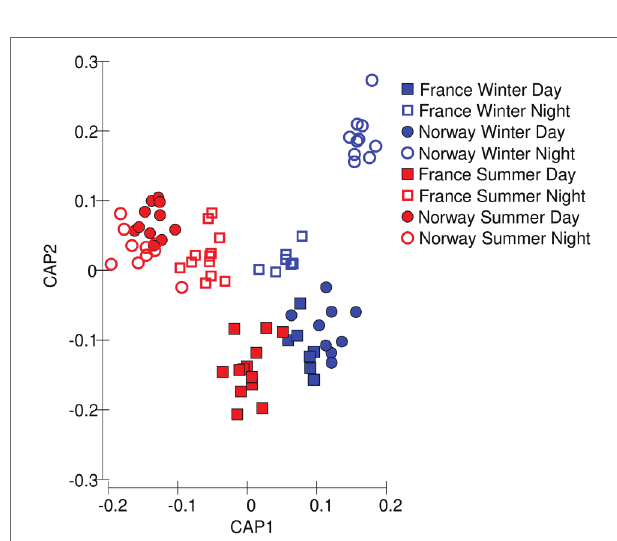
FIGURE 3 | Multivariate differences among samples in photochemical data, visualized as Euclidean distances along the first two principal